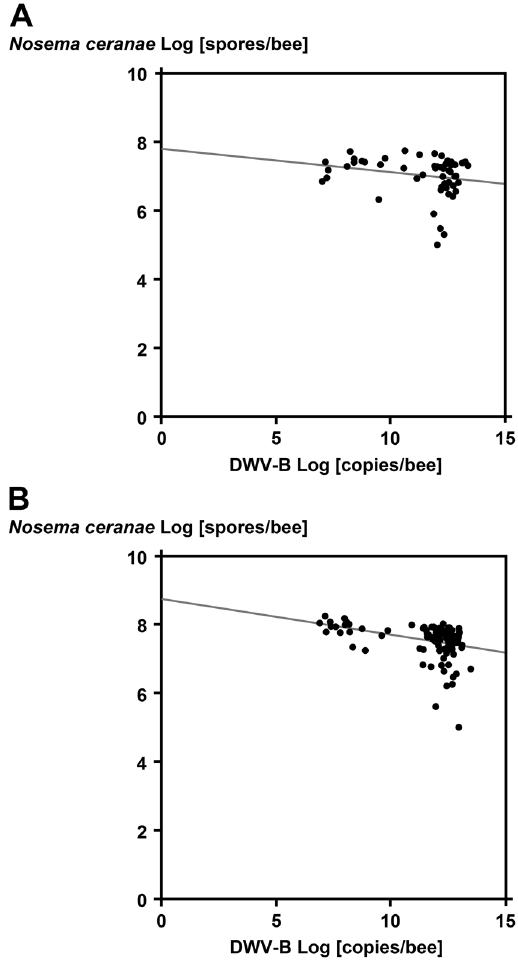
Figure 4. Correlations between N ceranae spore loads per bee and DWV-B copy numbers per bee in the treatment groups Nosema -only ( A ) and Nosema -pollen ( B ) at a log scale. While there was no significant correlation in the Nosema -only treatment (Pearson Correlation, Scatter Plot |r| = − 0.22, P = 0.12), a highly significant negative correlation was found in the Nosema -pollen treatment (Pearson Correlation, Scatter Plot |r| = − 0.34, P =